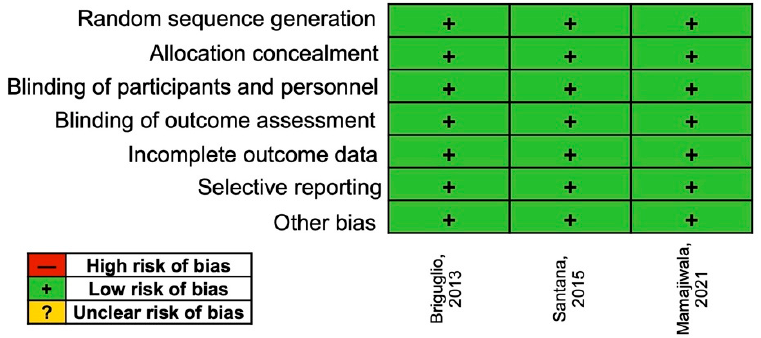
Figure 4. Risk of bias assessment.